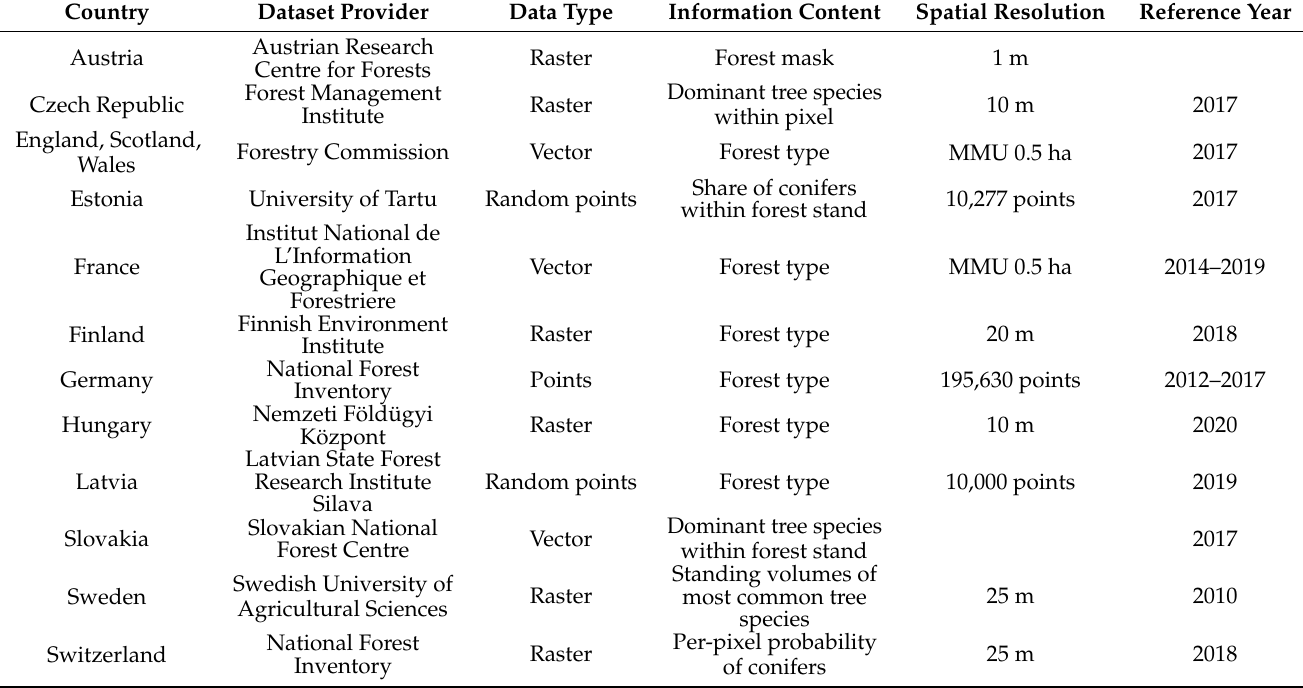
Figure 1. Overview of the national datasets that were used as reference. In the case of Austria, only a forest map of the federal state of Lower Austria was available. Table 1. Overview of the national datasets that were used as reference. In case of point-based datasets, the minimal mapping unit (MMU) is given in the Spatial resolution